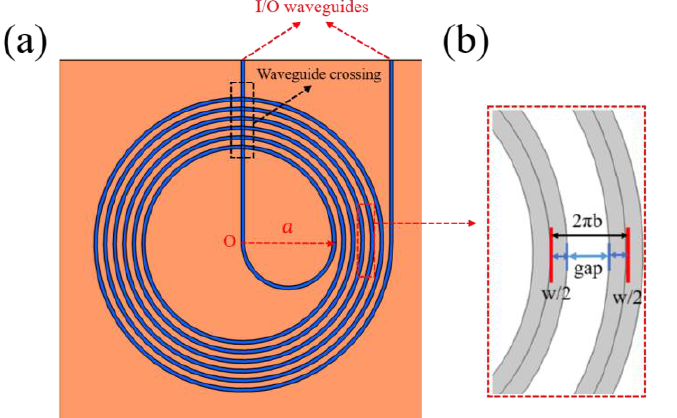
Figure 11. ( a ) Diagram of the Archimedes spiral structure designed as a passive sensitive gyroscope; ( b ) instructions for setting parameters between adjacent waveguide structures. ( b ) instructions for setting parameters between adjacent waveguide